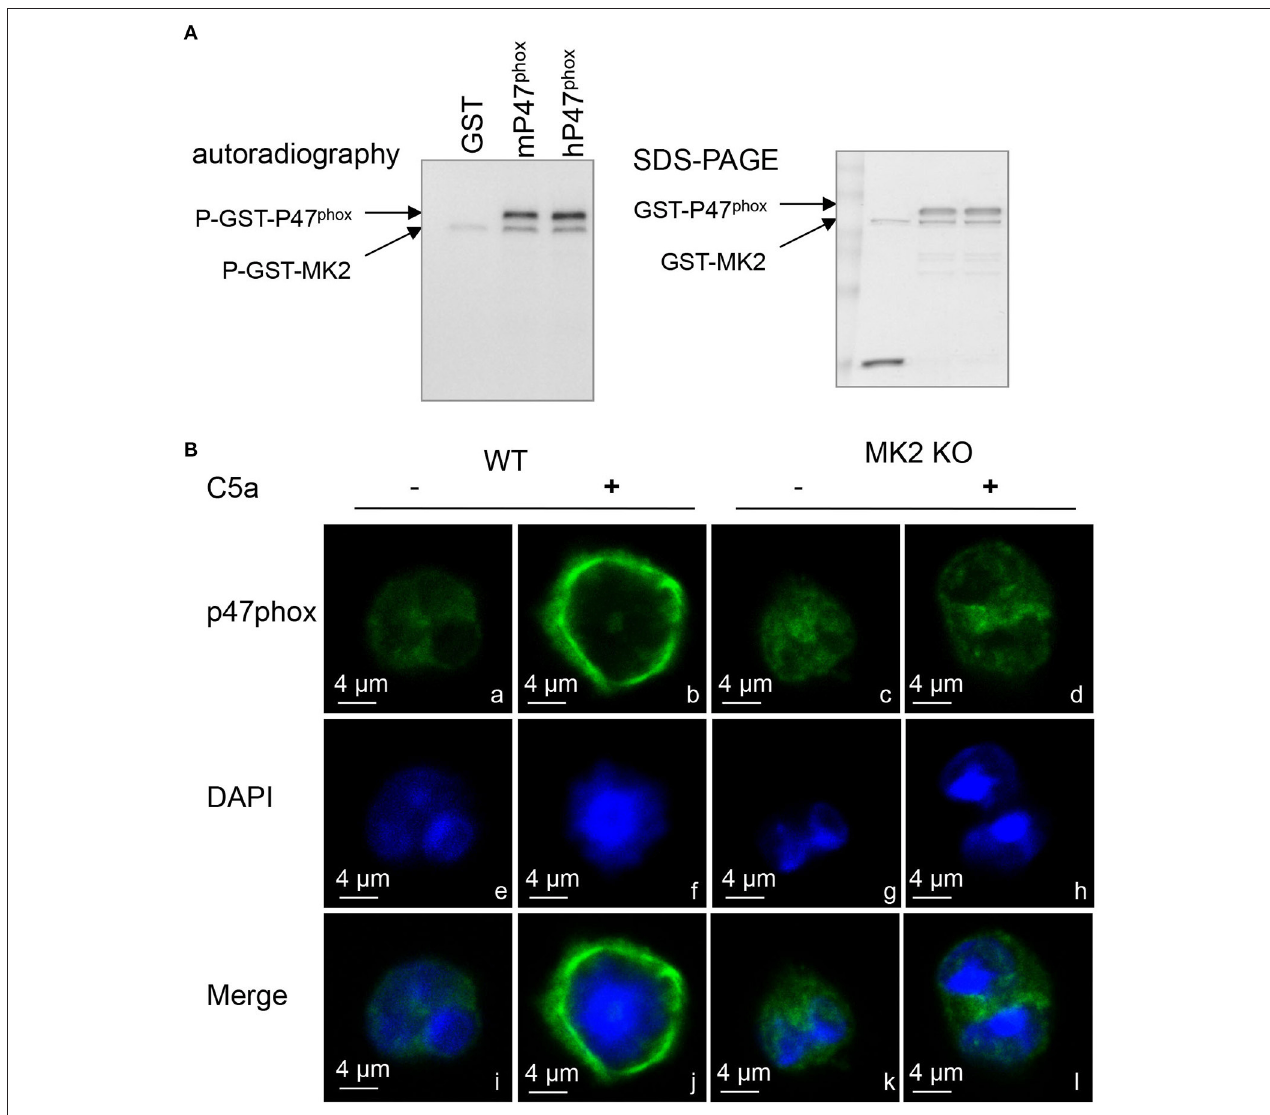
FIGURE 6 | MK2 directly regulated p47 phox phosphorylation and membrane translocation. (A) Autoradiograph of in vitro kinase assay using full-length human p47 phox (hp47 phox ) or mouse p47 phox (mp47 phox ) fused to GST as substrates for GST-MK2. GST without mp47 phox was used as a negative control. Two phosphorylated bands were identified in the autoradiograph: a phosphorylated GST–p47 phox , and an autophosphorylated GST-MK2. The loading levels of each protein were indicated in coomassie blue staining (right). (B) Neutrophils from MK2 + / + and MK2 − / − mice were treated with C5a (100nM) for 2min and immunofluorescence imaging was performed to detect the localization of p47 phox (green). Nuclei were stained with DAPI (blue). The results are representatives of three independent experiments, scale bar is 4 µ